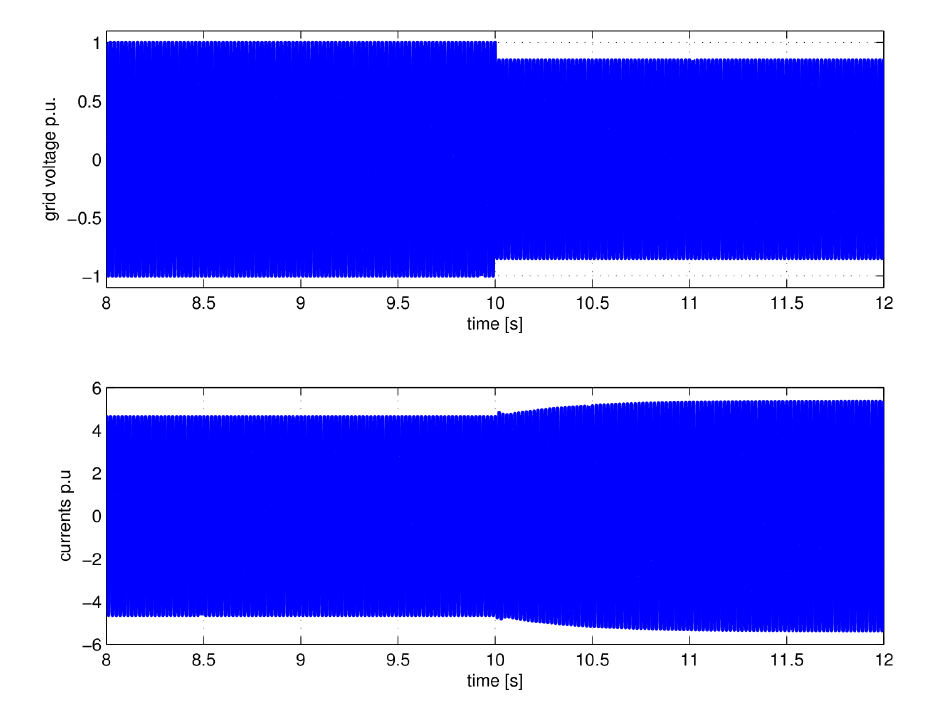
Figure 13. Simulated transients of i